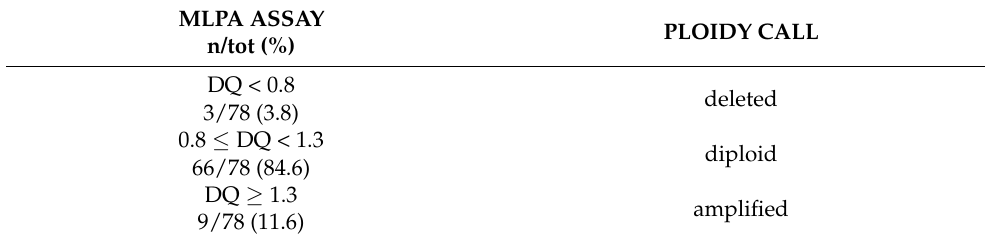
Table 1. Identification of deleted, diploid and amplified cases according to MLPA